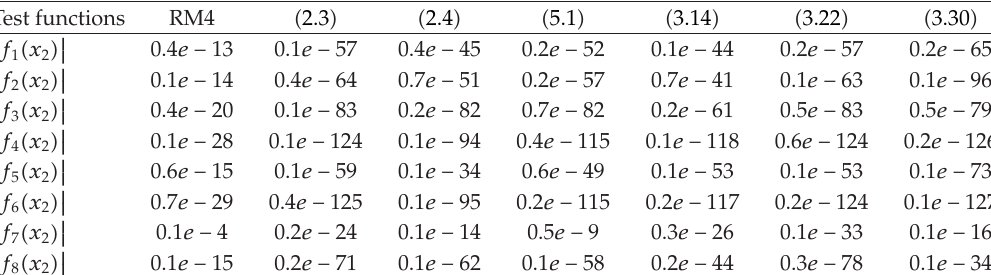
Table 3: Results of comparisons for di ff erent methods after two full iterations. Test functions